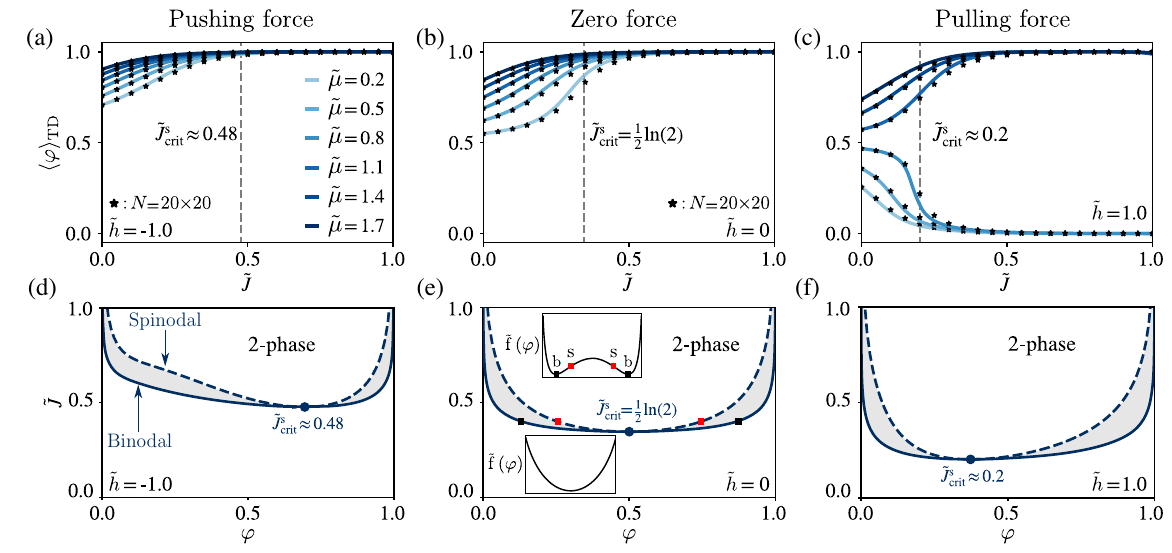
FIG. 4. Equation of state and phase diagram in the thermodynamic limit. (a) – (c) h φ i for a cluster of 20 × 20 adhesion bonds on a ˜ J from Eq. (13) as a function of the dimensionless coupling for various square lattice (symbols) and the saddle-point asymptotic h φ i TD ˜ ˜ h ¼ − 1 , (b) no force, and (c) a pulling force h ¼ 1 . The dashed vertical line denotes the (statical) affinities ˜ μ and for (a) a pushing force critical coupling strength ˜ J s whereupon the system phase separates into dense and dilute phases of closed bonds. (d,e) Phase diagram crit ˜ ˜ h ¼ − 1 , (e) no force, and (f) a pulling force h ¼ 1 ; the full and dashed lines depict the binodal and spinodal lines, for (d) a pushing force respectively. The shaded area depicts the region where the system is metastable. The blue circle depicts the (statical) critical point ˜ ˜ J < ˜ J s ; ˜ J s f ð φ Þ below the critical coupling (bottom) displaying a single Þ . Inset in (e): schematic of the free energy landscape ð φ s crit crit crit ˜ J > ˜ J s (top), with the black and red symbols illustrating the minimum, and a bistable free energy landscape above the critical coupling crit meaning of the phase compositions highlighted in the phase